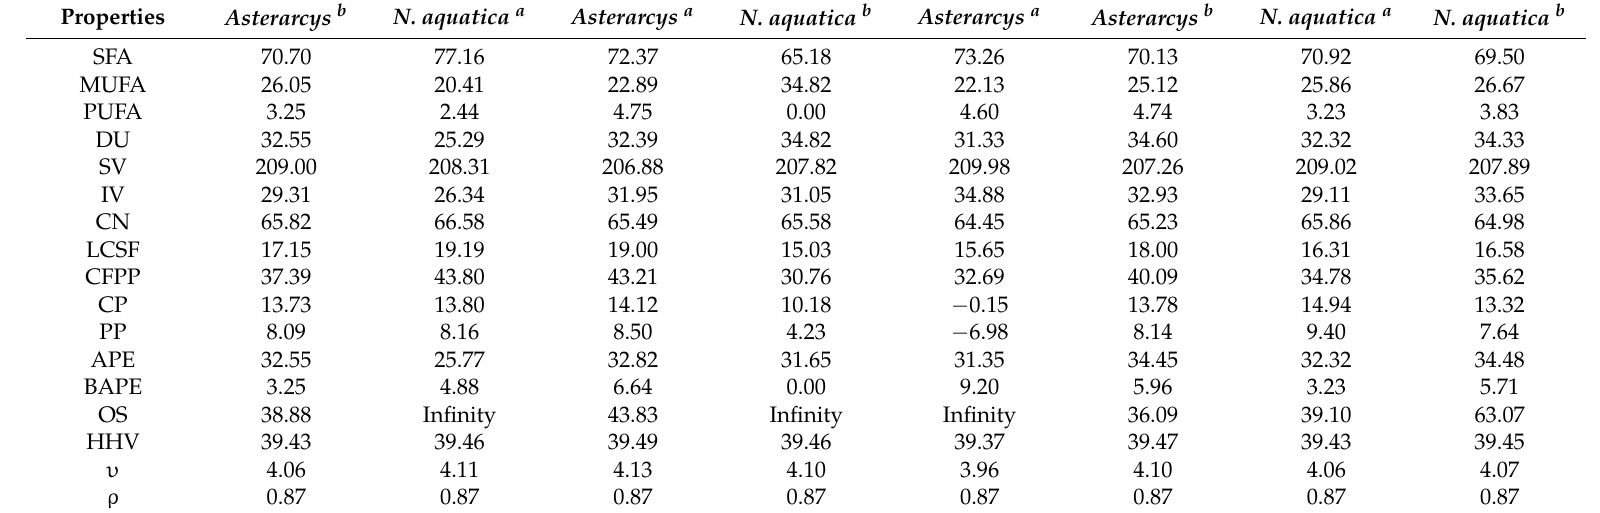
Table 3. Biodiesel characteristics of microalgae grown in sterilized and raw treated wastewater